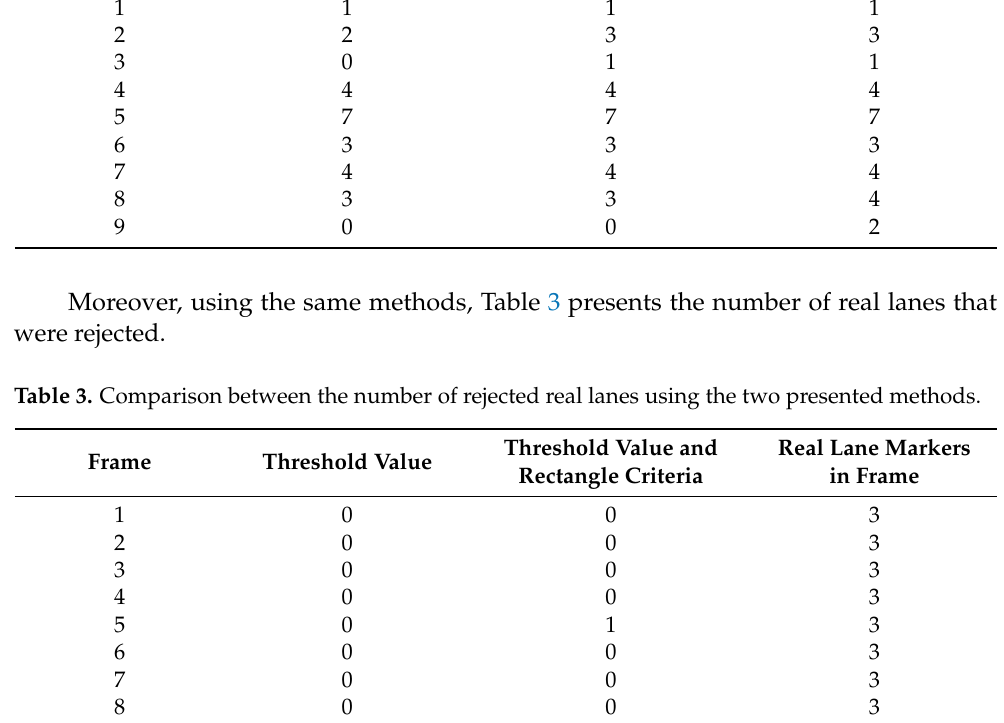
Table 2. Comparison between the number of rejected false lanes using the two presented methods. Frame